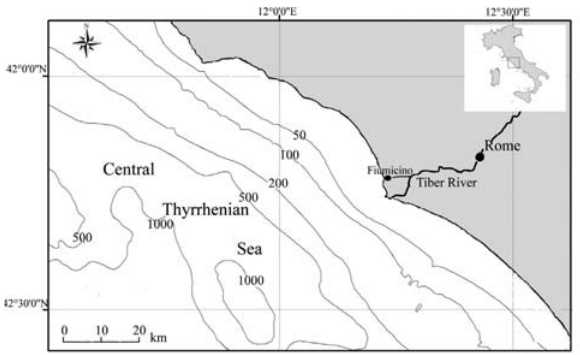
F IG . 1. – Map of trawl fishing grounds of Fiumicino landing harbour.